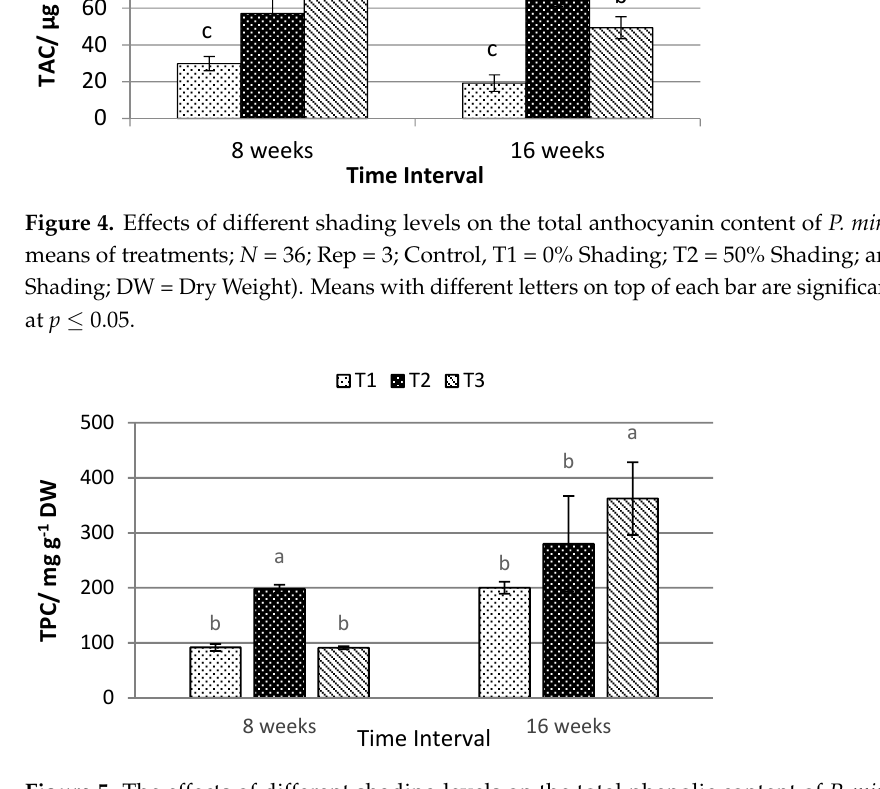
Figure 5. The effects of different shading levels on the total phenolic content of P. minus (data are means of treatments, N = 36; Rep = 3; Control, T1 = 0% Shading; T2 = 50% Shading and T3 = 70% Shading; DW = Dry Weight). Means with different letters on top of each bar are significantly different at p ≤ 0.05.